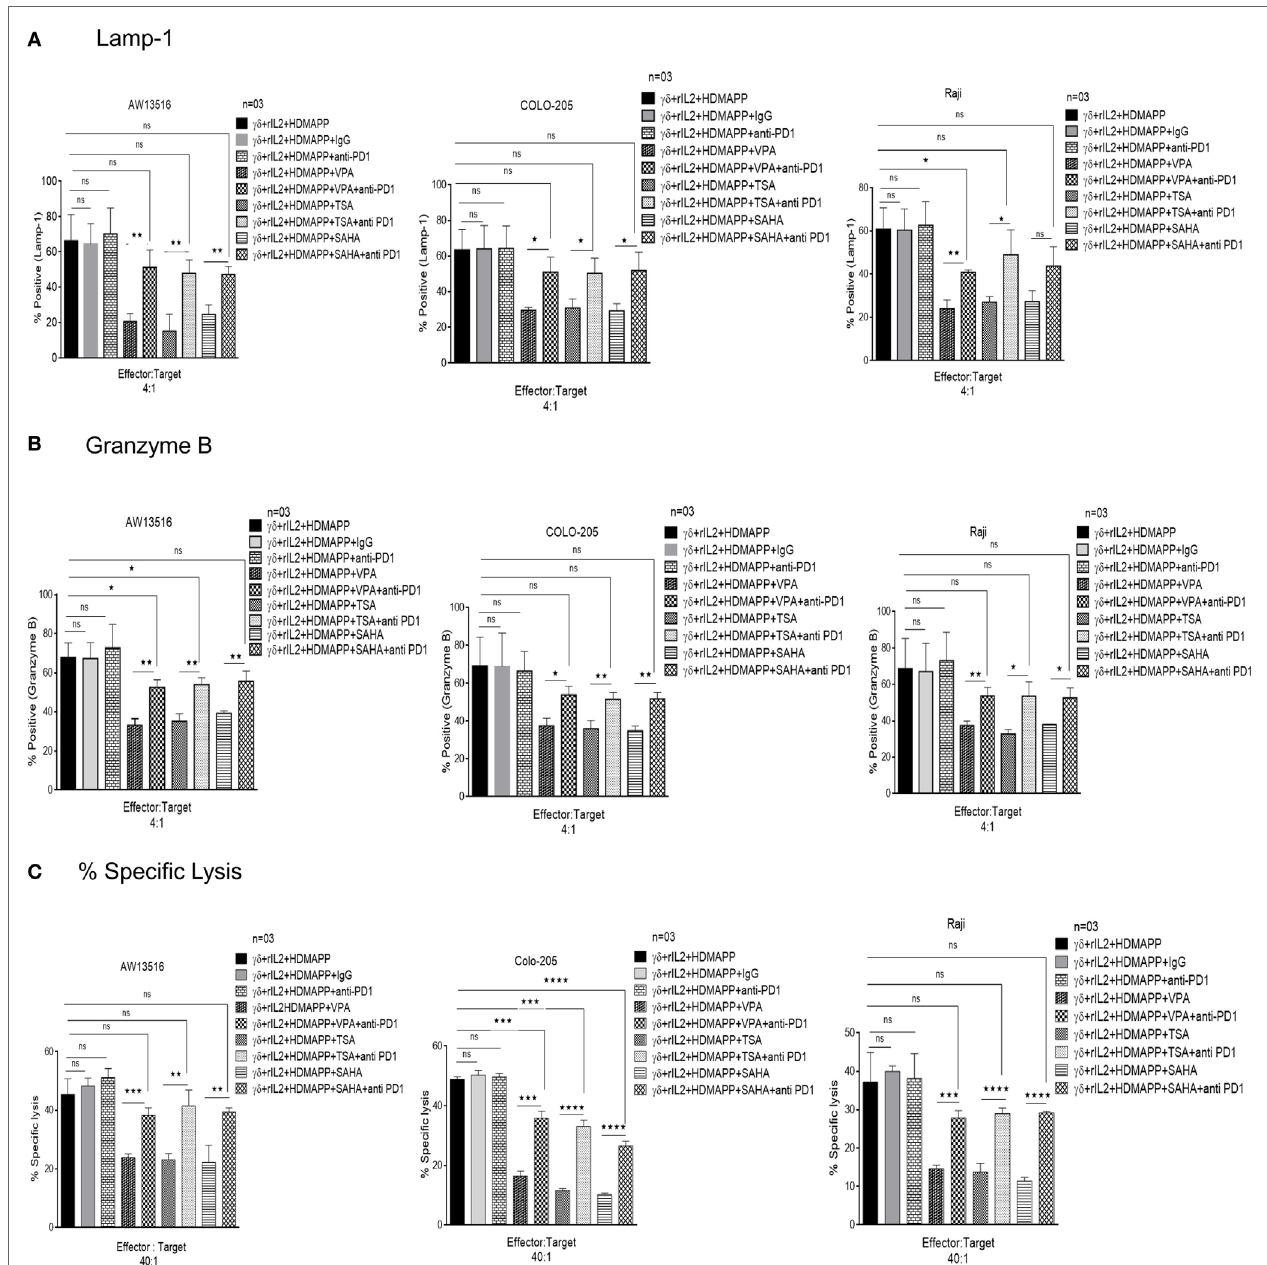
FigUre 8 | Histone deacetylases (HDAC) inhibitors abrogate effector functions of γδ T cells via programmed death-1 (PD-1) upregulation. Expression of of (a) degranulation marker CD107a and (B) granzyme B by γδ T cells was assessed by flow cytometric analysis. HDMAPP activated γδ T cells upon treatment with sodium valproate (VPA) (2 mM), Trichostatin-A (TSA) (100 nM), and suberoylanilidehydroxamic acid (SAHA) (1 µM) in the presence or absence of PD1 blocking antibody were cocultured with three zoledronate treated tumor targets (AW 13516, Raji, COLO205) cells for 4 h at effector to target ratio of 4:1. The data represent consolidated median fluorescence intensity values of granzyme B and CD 107a expressing cells, indicative of three independent experiments (** p < 0.005, * p < 0.05, and ns, not significant). (c) The cytotoxic ability of γδ T cells treated with HDAC inhibitors TSA, SAHA, and VPA in the presence or absence of PD-1 blocking antibody was assessed against three zoledronate treated tumor targets (AW 13516, Raji, COLO205) by lactate dehydrogenase cytotoxicity assay. HDAC inhibitor treated γδ T cells show increased cytotoxic potential in the presence of PD-1 blocking antibody. The results indicate percent cytotoxicity where ** p < 0.005, *** p < 0.0005, and ns, not significant, when compared with HDMAPP-activated γδ T cells treated with the respective HDAC inhibitor. Data represent three independent